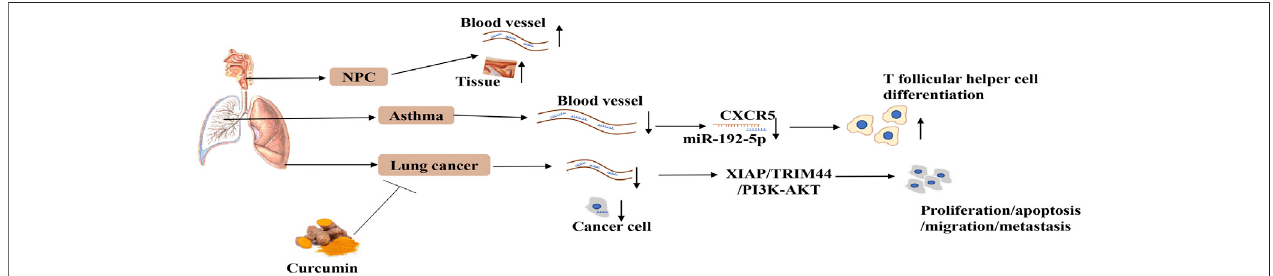
FIGURE 2 | The expression and regulatory mechanism of miR-192-5p in respiratory system. MiR-192-5p is reduced in serum of human asthma, NPC and lung cancer, as well as NPC tissues and lung cancer cell, which can in fl uence diseases progression by targeting CXCR5, XIAP, TRIM44, and PI3K-AKT. Curcumin can promote the expression of miR-192-5p.